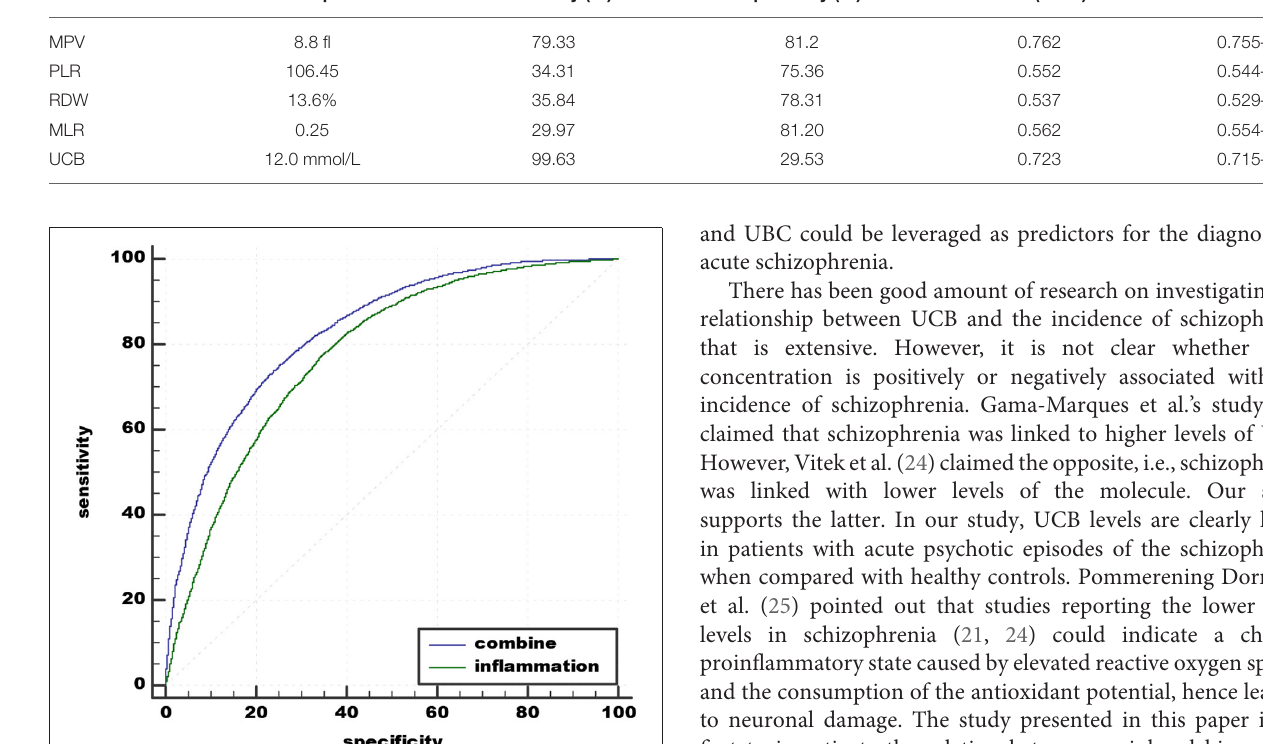
TABLE 5 | Admission of peripheral biomarkers of inflammation derived from CBC and UCB as predictors for diagnosis of acute schizophrenia. Variables